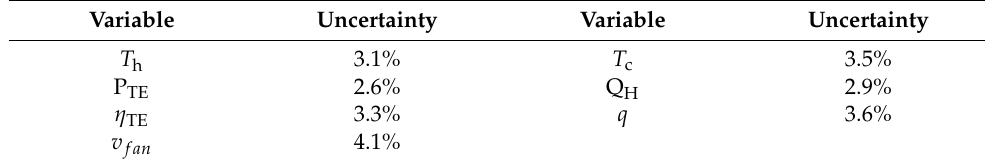
Table 3. Uncertainty for measured variable.